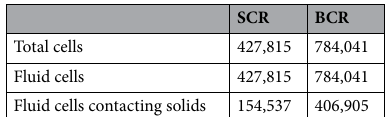
Table 2. Number of cells in the BCR and